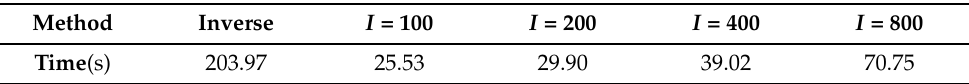
Figure 12. The NMSE of the reproduced intensity using the direct inverse and the adopted CG method. I = 100,200,400,800 is the iteration number of CG. The reverberation time RT 60 = 200 ms and the control filter length J = 400. Table 3. The processing time of the direct inverse operation and the CG method, where the cor- responding computational complexity is O (( LJ ) 3 ) and O ( I ( LJ ) 2 ) , respectively. I is the iteration number of the CG method. The reverberation time RT 60 = 200 ms and the control filter length J =